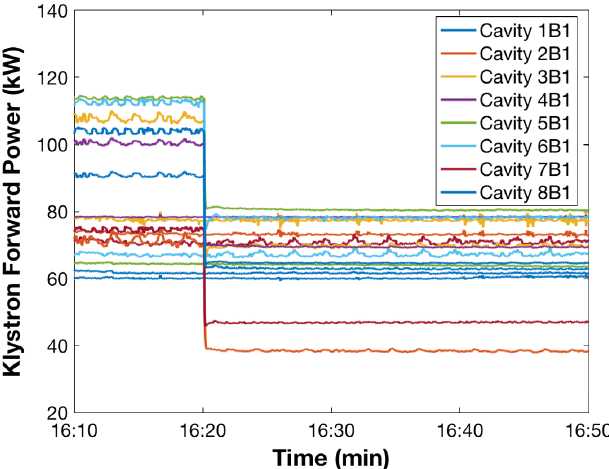
FIG. 20. ATLAS and CMS instantaneous